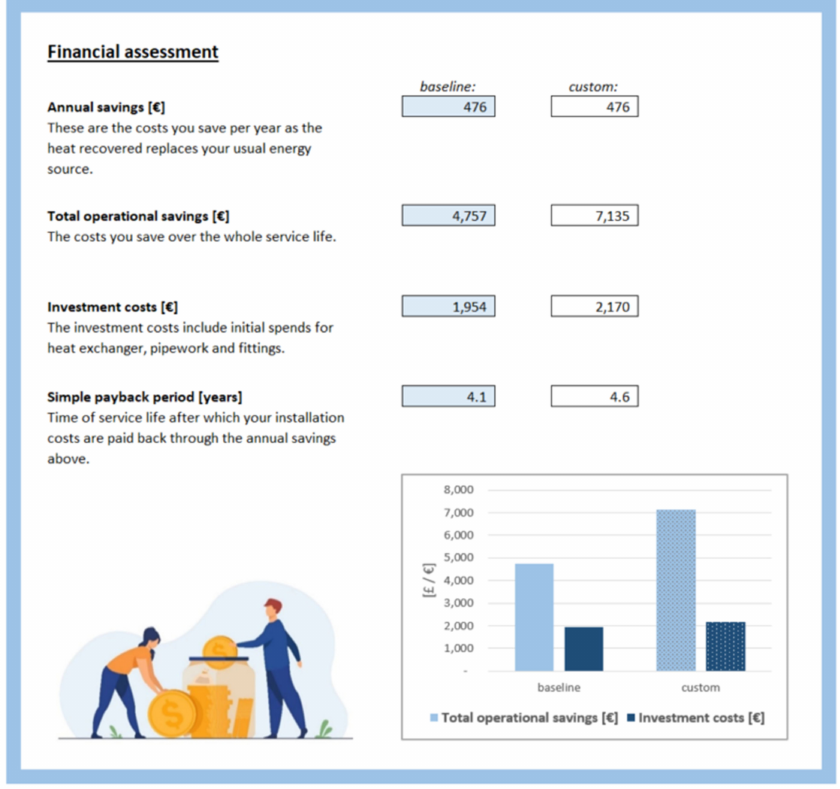
Figure 3. Example for results of the financial assessment of the heat recovery toolkit. Assumptions: water consumption of 2000 m 3 /year; natural gas as heating fuel at a rate of 3.1 Eurocent/kWh [40]; country: Ireland; distance between kitchen drain and boiler of 10 m. Baseline: 10-year service life and pipework from polyethylene. Custom: 15-year service life and pipework from steel. With graphical element modified from